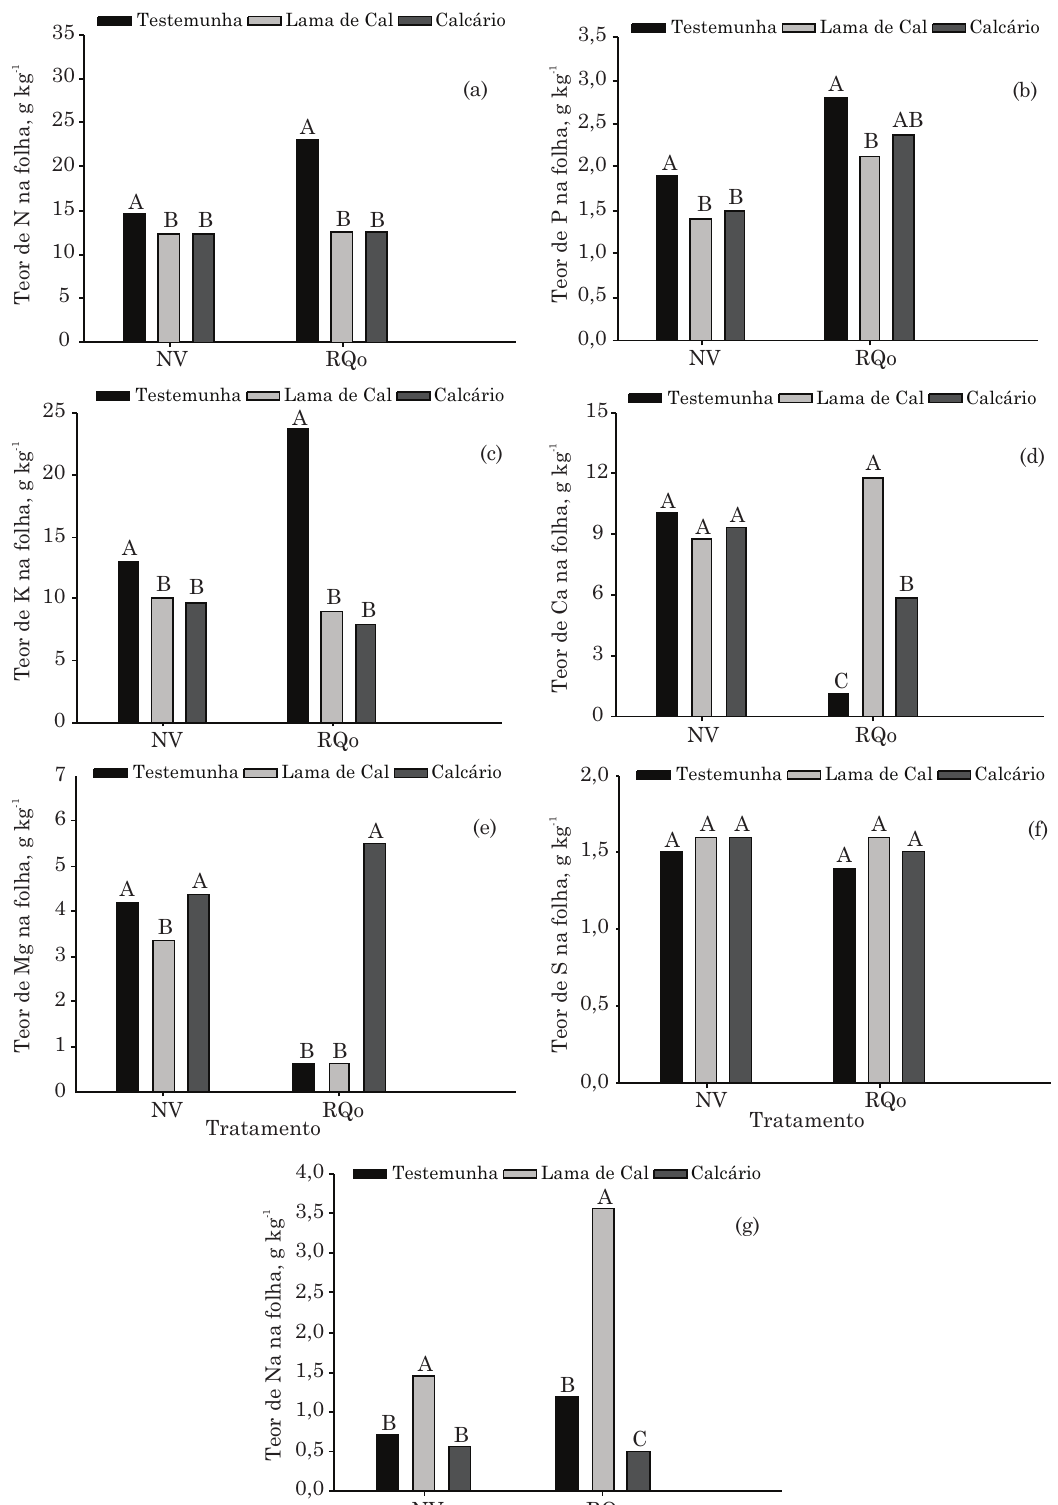
Figura 2. Teores de N (a), P (b), K (c), Ca (d), Mg (e), S (f) e Na (g) nas folhas de plantas de Eucalyptus saligna cultivadas em Nitossolo Vermelho eutroférrico (NV) e Neossolo Quartzarênico órtico (RQo), em função da aplicação de calcário dolomítico e lama de cal. Médias seguidas da mesma letra, no mesmo solo, não diferem significativamente pelo teste de Tukey a 5